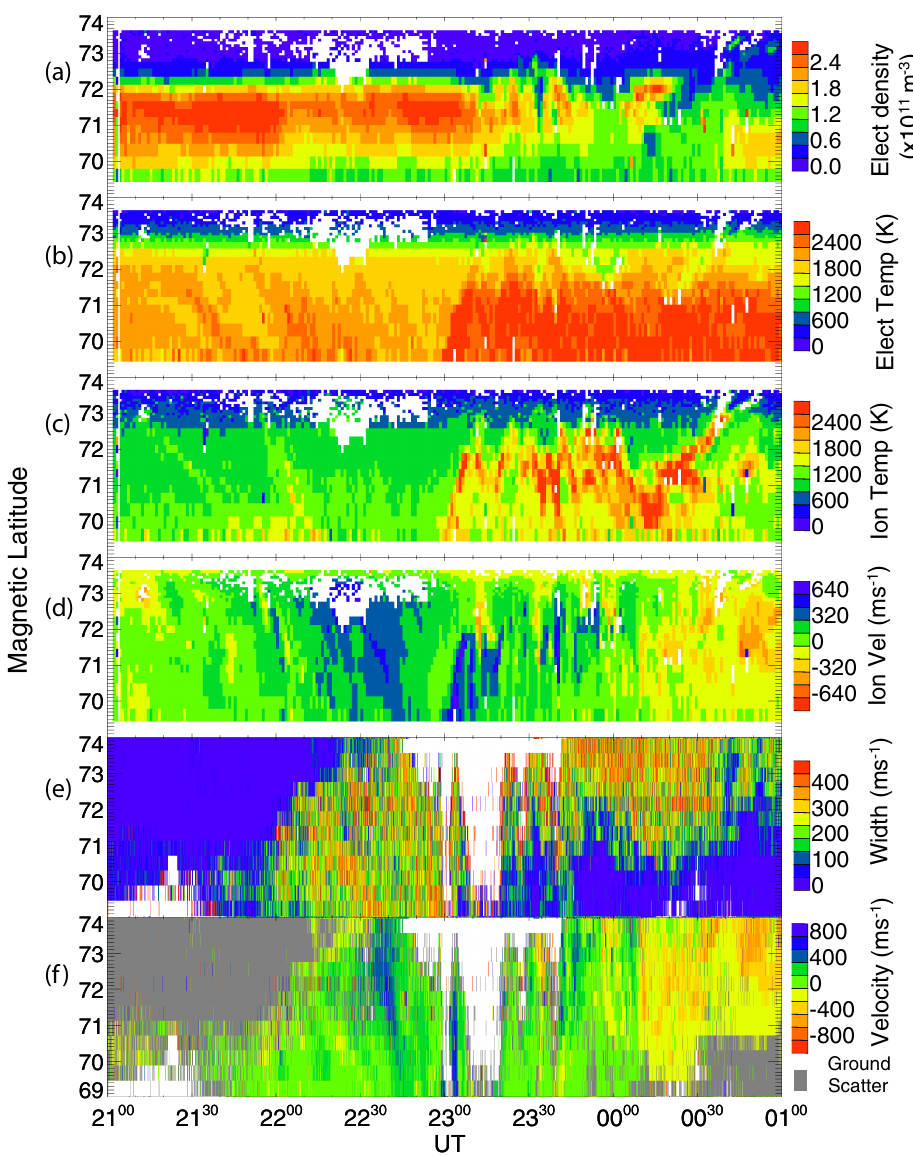
Fig. 10. Data from 21 to 22 August 1998. Panels (a) to (d) are observations from the ESR radar, electron density, electron temperature, ion temperature and ion line-of-sight velocity (negative values are towards the radar) respectively. Panel (e) shows CUTLASS Finland, beam 9, spectral width data and panel (f) shows the beam 9 line-of-sight velocity (negative values are away from the radar) both at high time